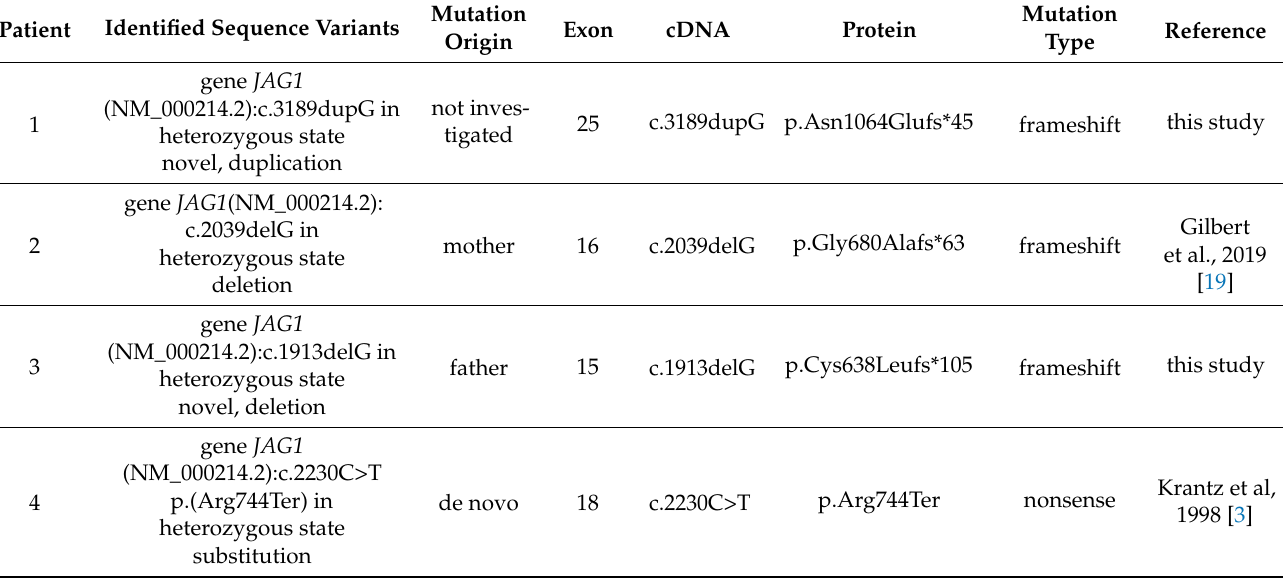
Table 2. Pathogenetic variants in JAG1 found in patients with Alagille